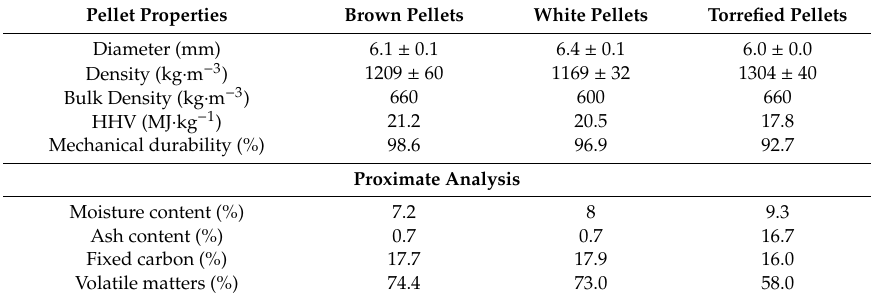
Table 2. As-received physicochemical properties of pellets used in this